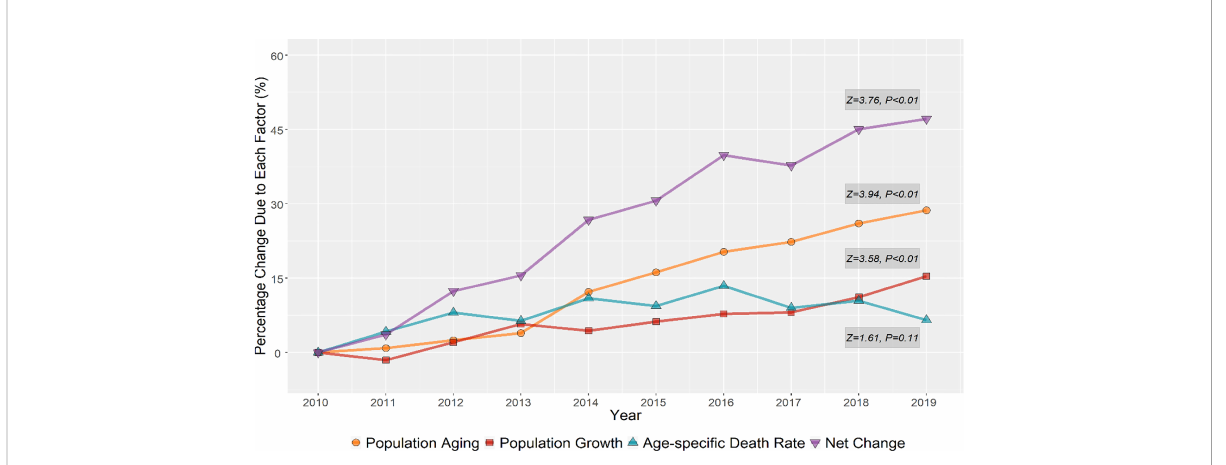
FIGURE 1 Relative contributions of changes in population aging, population growth, and age-speci fi c lung cancer mortality rate to variations of lung cancer deaths in the population of Wuhan,